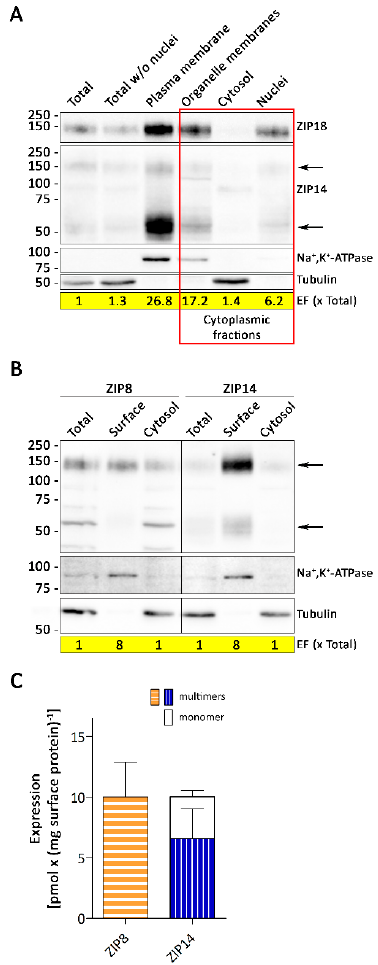
Figure 6. Subcellular localization of ZIP8 and ZIP14 in A549 cells. (A) Plasma membranes and three cytoplasmic fractions were isolated from whole-cell lysates (Total); 40 μ g of each fraction was analyzed by immunoblotting for ZIP8 and ZIP14. The fractions were enriched compared to the whole- cell lysate by the enrichment factors (EF) indicated. Na + , K + -ATPase, and Tubulin served as plasma membrane and cytosolic markers, respectively. (B,C) A549 cultures were subjected to surface biotinylation with cell membrane impermeable Sulfo-NHS-SS-biotin after which the cells were lysed in 1000 μ L NETT buffer. Biotin-labeled cell-surface proteins were isolated from 800 μ L whole-cell lysates using NeutrAvidin agarose beads and eluted in 100 μ L sample buffer. (B) 40 μ L of whole-cell lysates (Total), biotin-labeled cell-surface proteins (Surface) and flow-through (Cytosol) were analyzed by immunoblotting for ZIP8 and ZIP14. Cell surface proteins were enriched compared to whole-cell lysates by a factor of 8. Na + , K + -ATPase, and Tubulin served as the surface and cytosolic markers, respectively. (C) Specific amounts of membrane localized ZIP8 and ZIP14 (monomeric +